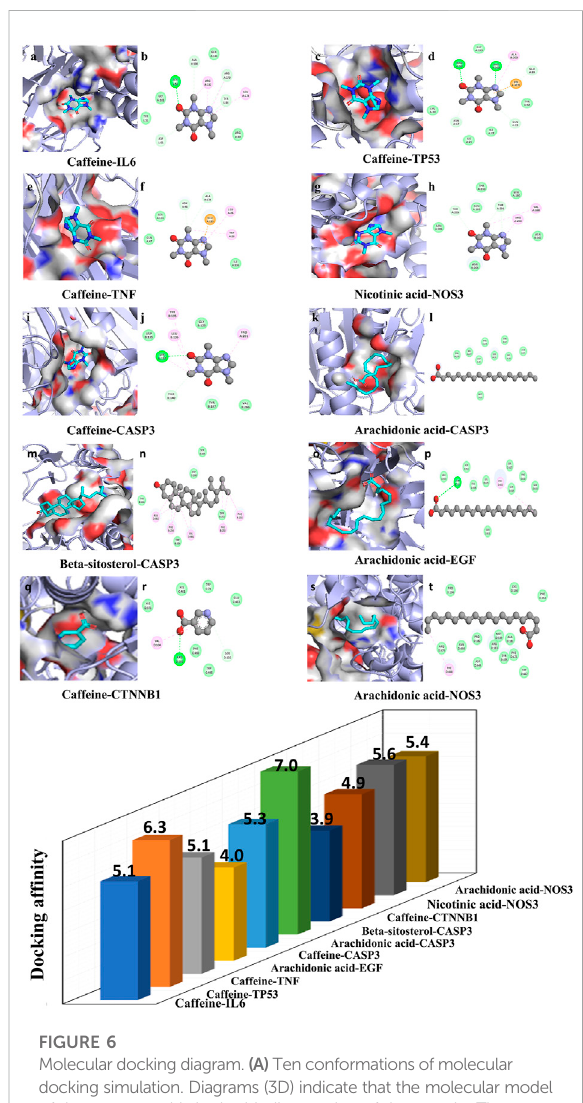
FIGURE 6 Moleculardockingdiagram. (A) Tenconformationsofmolecular docking simulation. Diagrams (3D) indicate that the molecular model of the compound is in the binding pocket of the protein. The compound is shown as a stick model with orange coloring. The amino acid residues surrounding are represented by surface style (A,C,E,G,I,K,M,O,Q,S) . Diagrams (2D) show the interactions between thecompoundandsurroundingresidues (B,D,F,H,J,L,N,P,R,T) . (B) The 3D column diagram shows the af fi nity of 10 conformations. X -axis: bioactive component, Y -axis: target names, Z -axis: docking af fi nity (absolute value of the binding energy). Taking the caffeine-IL6 docking, for example, the small molecule ligand caffeine potentially fi ts into the interface pocket formed by the interaction of amino acid residues in protein (Figure 6A). As shown in Figure 6 (B) , a hydrogen bond was formed with caffeine SER52 near the active site of IL6. The other essential residues (ASP55, TUR51, GLY101, ALA100, GLN183, ARG182, ARG179, TYR34, LEU178 and ARG30)throughvander Waal ’ s forces, carbon hydrogen bond, pi-donor hydrogen bond, pi – pi T-shaped, alkyl, and pi – alkyl. These forms of hydrogen bonds and interactions contribute to the stability of the binding of small molecules to the active sites of